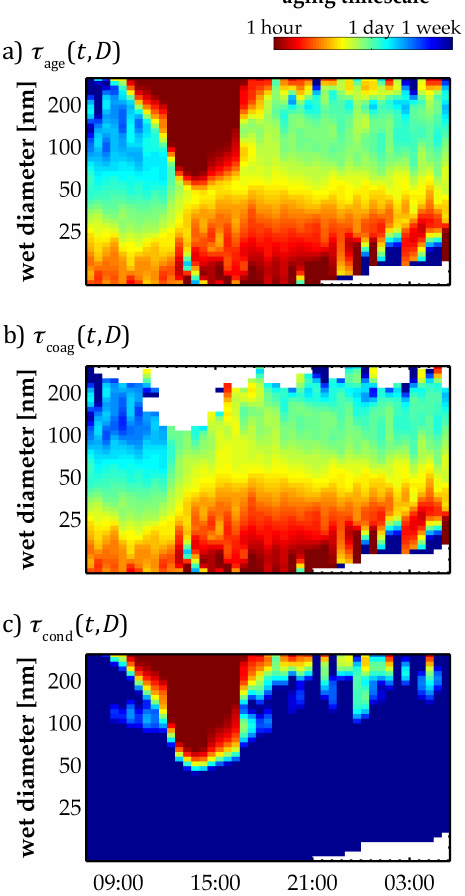
Figure 7. For baseline scenario, (a) overall size-dependent aging timescale, (b) condensation aging timescale, and (c) coagulation ag- ing timescale. Values are shown for s = 0 .